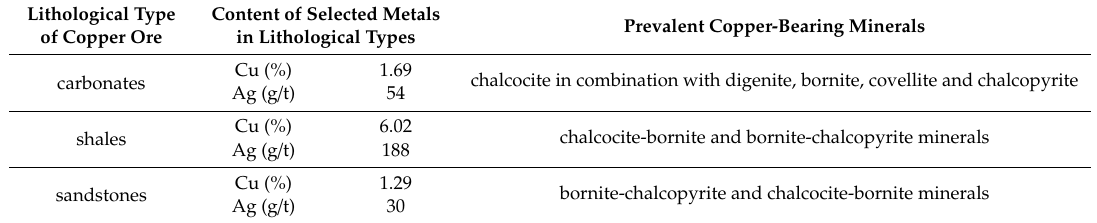
Table 1. Mineralogical composition of lithological types of Polish copper ores. Lithological Type Content of Selected Metals of Copper Ore in Lithological Types